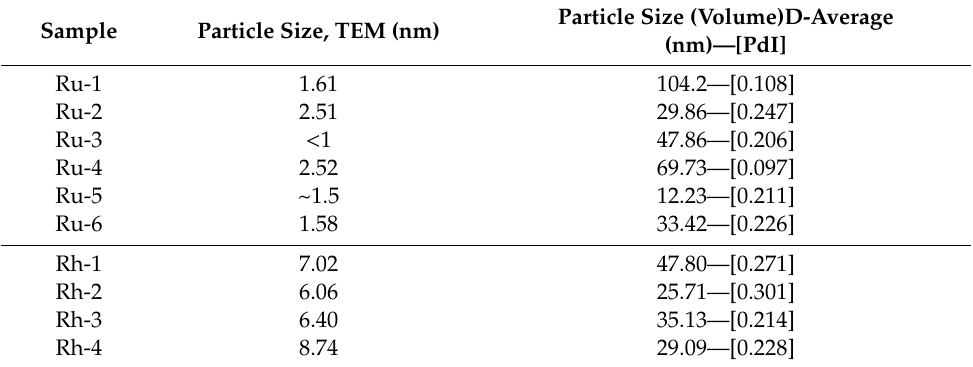
Table 2. Particle size estimations for as-synthesized Ru and Rh NPs according to Table 1. Average particle sizes obtained by counting particles from TEM micrographs, and by DLS measurements reported in hydrodynamic volume %; polydispersity index (PdI) is also provided for the DLS measurements.